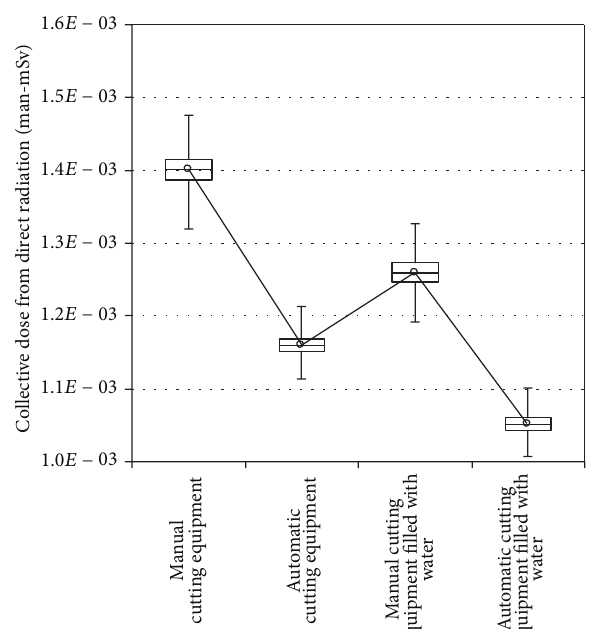
Figure 4: Dose rate maps.